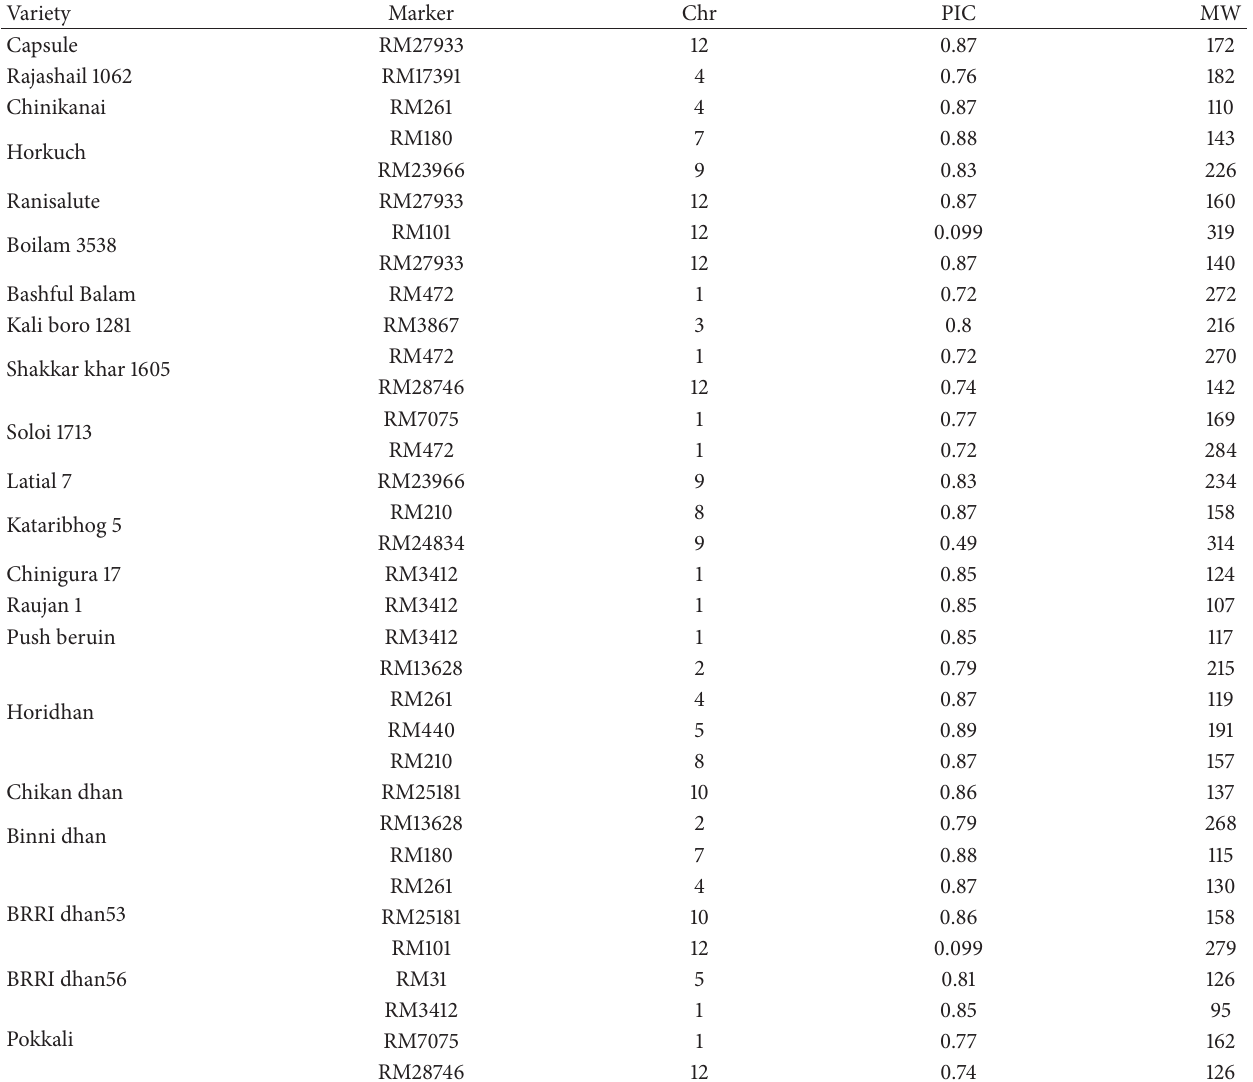
Table 3: List of 34 unique identifiers found from the